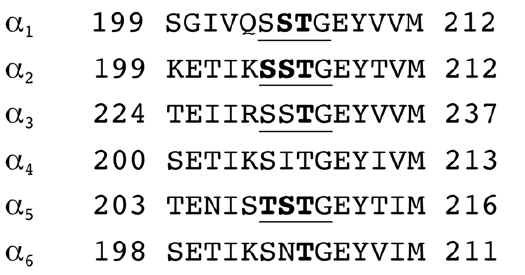
Figure 2. Alignment of Loop C of the a subunits. The underlined residues were individually mutated to cysteine. The bold residues react covalently with 3-NCS. a 4 was not investigated and is only shown for